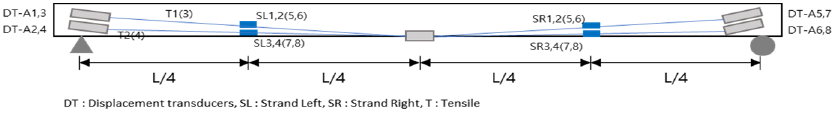
Figure 9. Positions of reinforcement gauges used for the EP method.